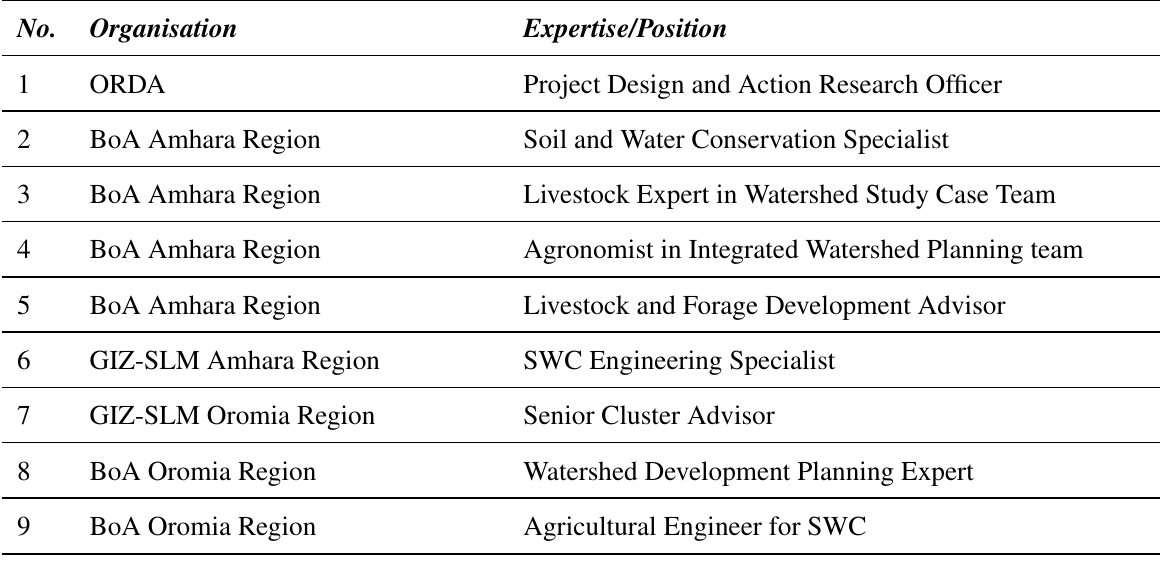
Table 1. List of workshop participants. SWC, soil and water conservation.